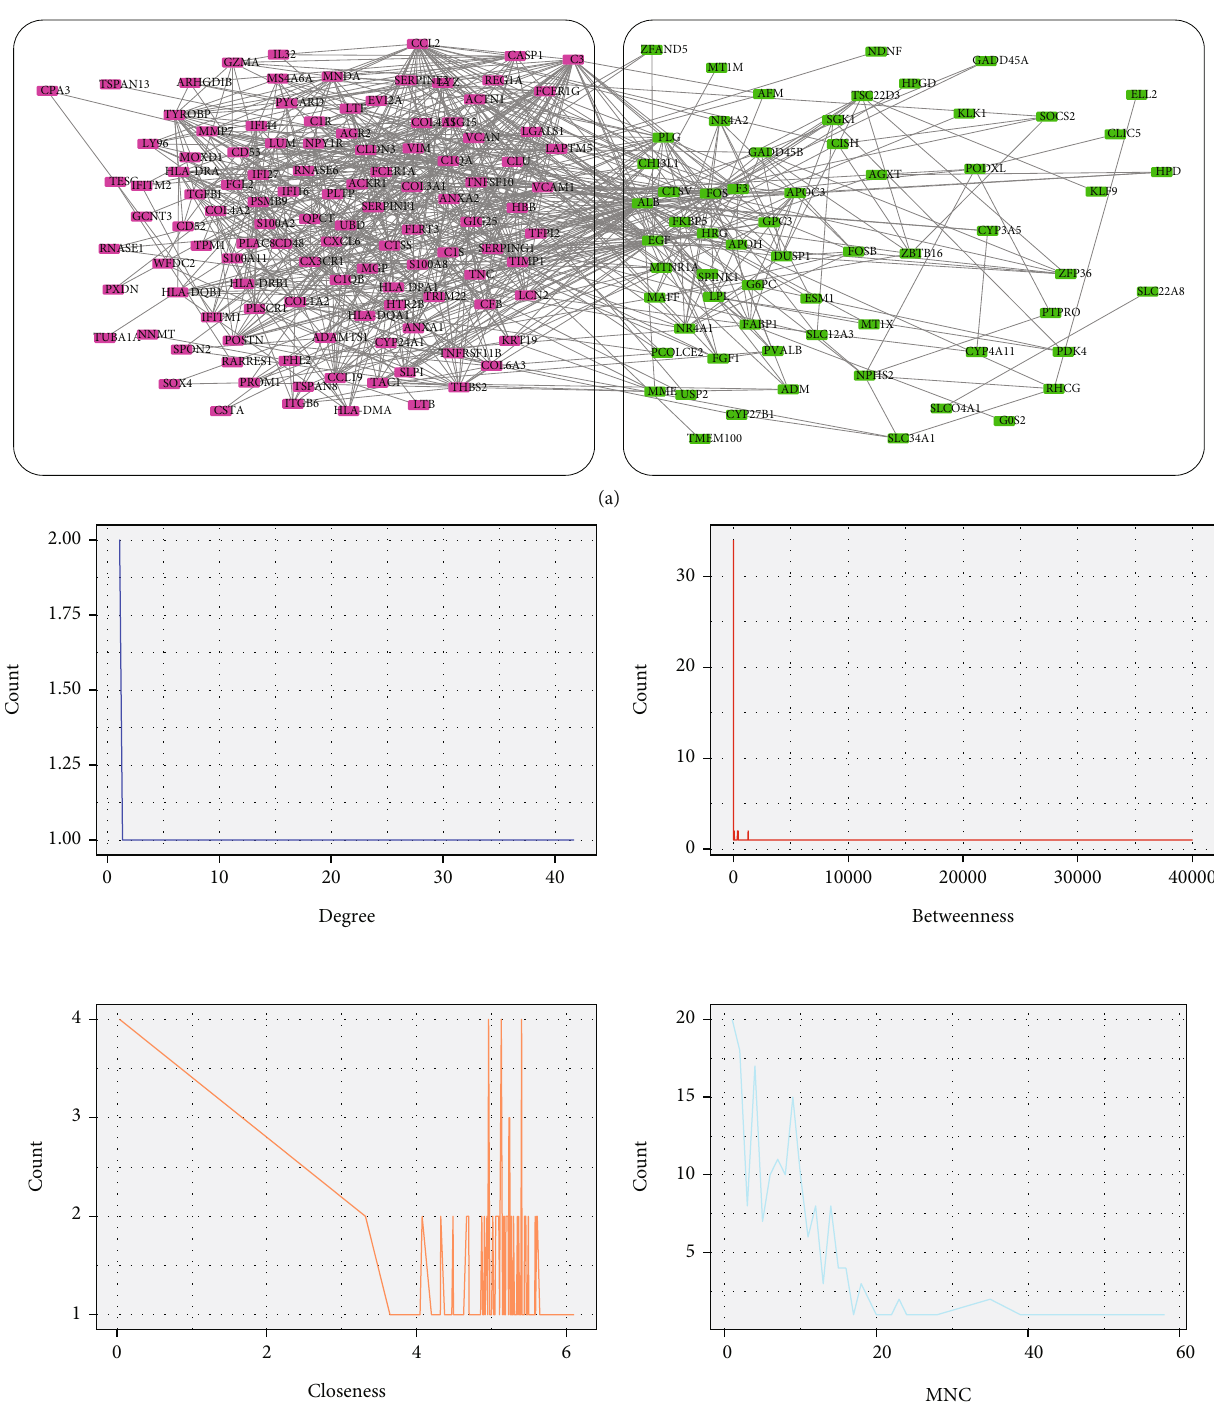
Figure 4: PPI network analysis and key genes ’ recognition. (a) PPI network for DEGs. Red rectangle node: upregulated genes; green rectangle node: downregulated genes. (b) Key genes were screened using Cytoscape cytoHubba plugin based on the four methods, Degree, Betweenness, Closeness, and MNC. PPI: protein – protein